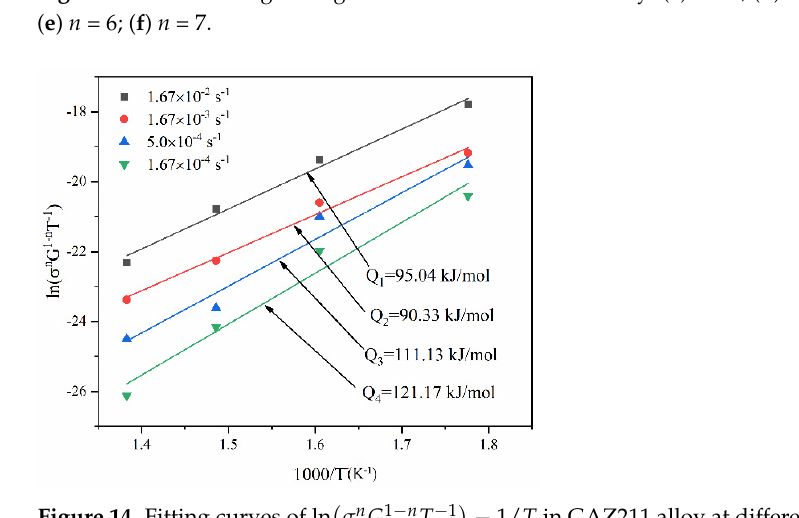
Figure 14. Fitting curves of ln(𝜎 (cid:3041) 𝐺 (cid:2869)(cid:2879)(cid:3041) 𝑇 (cid:2879)(cid:2869) ) − 1/𝑇 in GAZ211 alloy at different strain rates. (3) Normalized curve